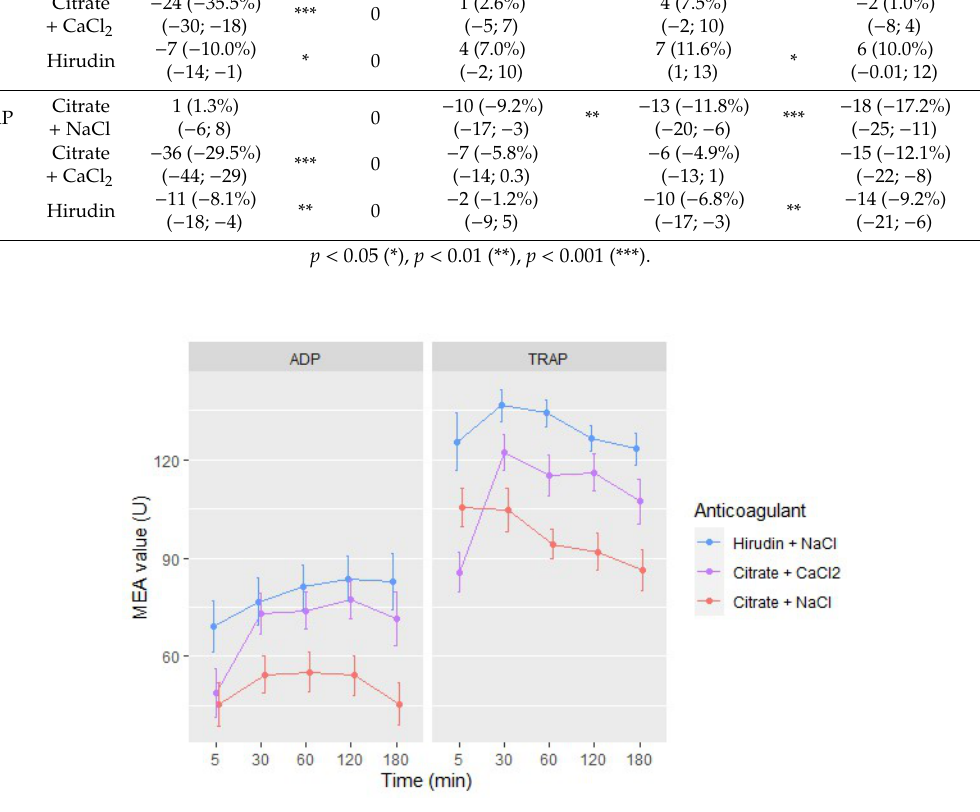
Figure 5. Mean MEA values (U) according to the time elapsed between blood draw and testing. Blue lines represent tests performed with blood samples anticoagulated with hirudin and diluted with NaCl, purple lines with citrate and diluted with CaCl₂ and red ones with citrate and diluted with NaCl. Bars represent 95% CI of the mean. Table 3. Mean differences in MEA results at the five time points (30 min being the reference) for both activators and under the three anticoagulant conditions. MEA values are expressed in arbitrary units. Mean difference, relative difference (%) and 95% confidence interval for the mean difference are given for each value.